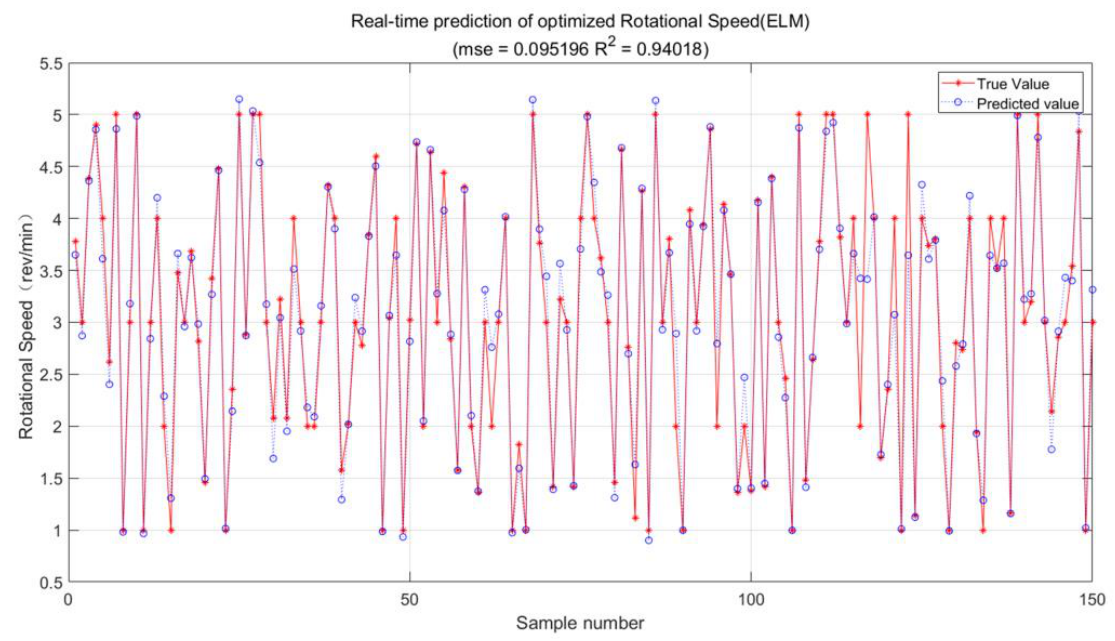
Figure 10. Real-time prediction of the optimized rotational speed.